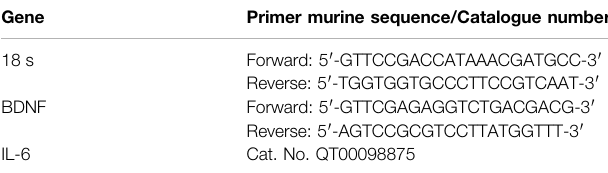
TABLE 1 | Primers used for